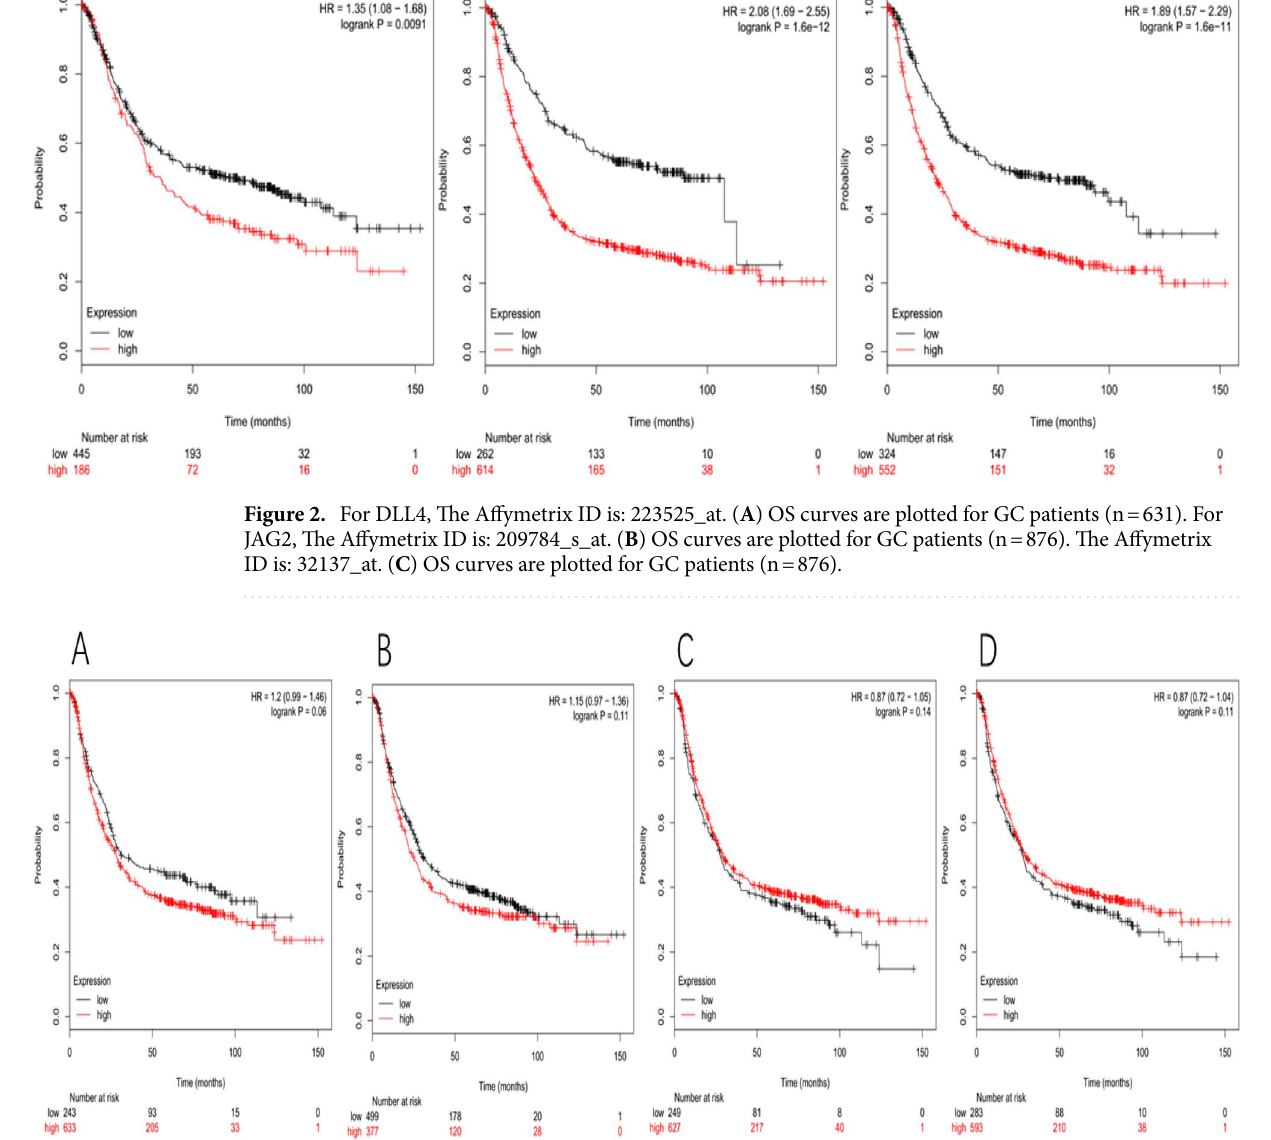
Figure 3. For JAG1, The Affymetrix ID is: 216268_s_at. ( A ) OS curves are plotted for GC patients (n = 876). The Affymetrix ID is: 209098_s_at. ( B ) OS curves are plotted for GC patients (n = 876). The Affymetrix ID is: 209099_x_at. ( C ) OS curves are plotted for GC patients (n = 876). The Affymetrix ID is: 216268_s_at. ( D ) OS curves are plotted for GC patients (n = mRNA expressions was tied to worsening OS in intestinal, HR 1.6 (1.02–2.57), p = 0.048. HR 1.88 (1.34–2.64), p = 0.0002. DLL4 expression was so clearly tied to worsening OS in diffuse, HR 1.5 (1.06–2.13), p = 0.021. High expression of JAG1 was linked to improving OS in intestinal, HR 0.63 (0.46–0.86), p = 0.004 and mixed, HR 0.16 (0.03–0.73), p = 0.008. JAG2 mRNA expression was so clearly tied to worsening OS in intestinal, HR 2.72